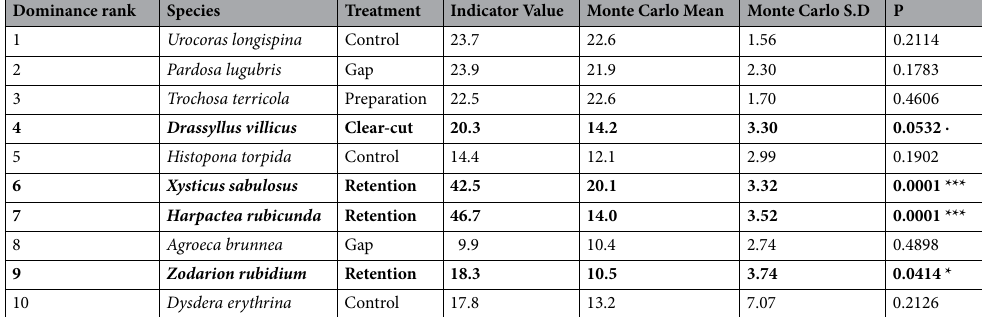
Table 1. Indicator Species Analysis results for the 10 most dominant species. Species with significant and marginally significant Indicator Values are highlighted in bold font. For family and author of species see Table